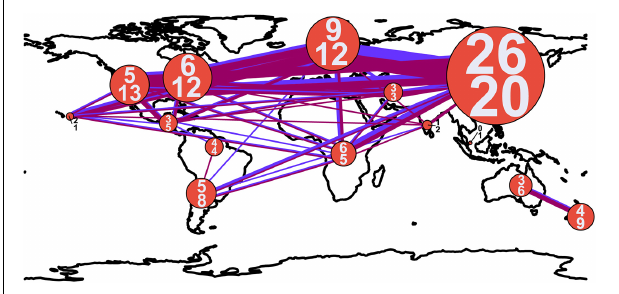
FIGURE 3 | Connectedness of biogeographic regions by shared armillarioid species clusters. The width of the lines and diameter of circles are proportional to the number of connections and number of species, respectively. The blue line corresponds to ITS1 and the magenta line to ITS2. The numbers within the circles indicate the number of armillarioid species clusters detected in each region, with the top number referring to the number of species clusters at ITS1 and the bottom number at